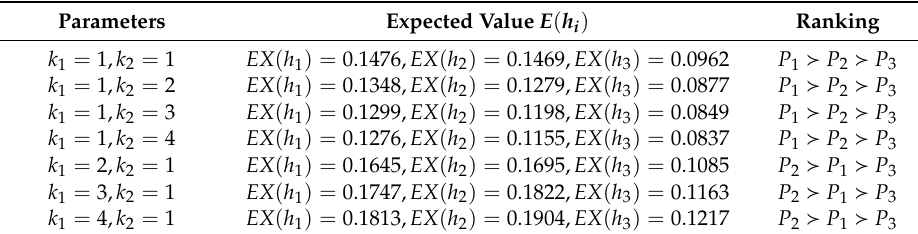
Table 5. Ranking results with di ff erent parameters k 1 , k 2 .